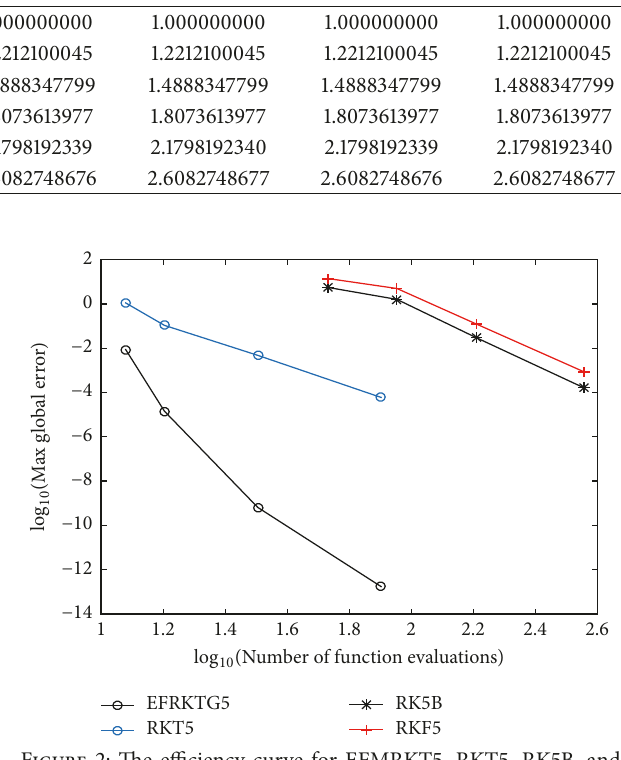
Figure 2: The efficiency curve for EFMRKT5, RKT5, RK5B,